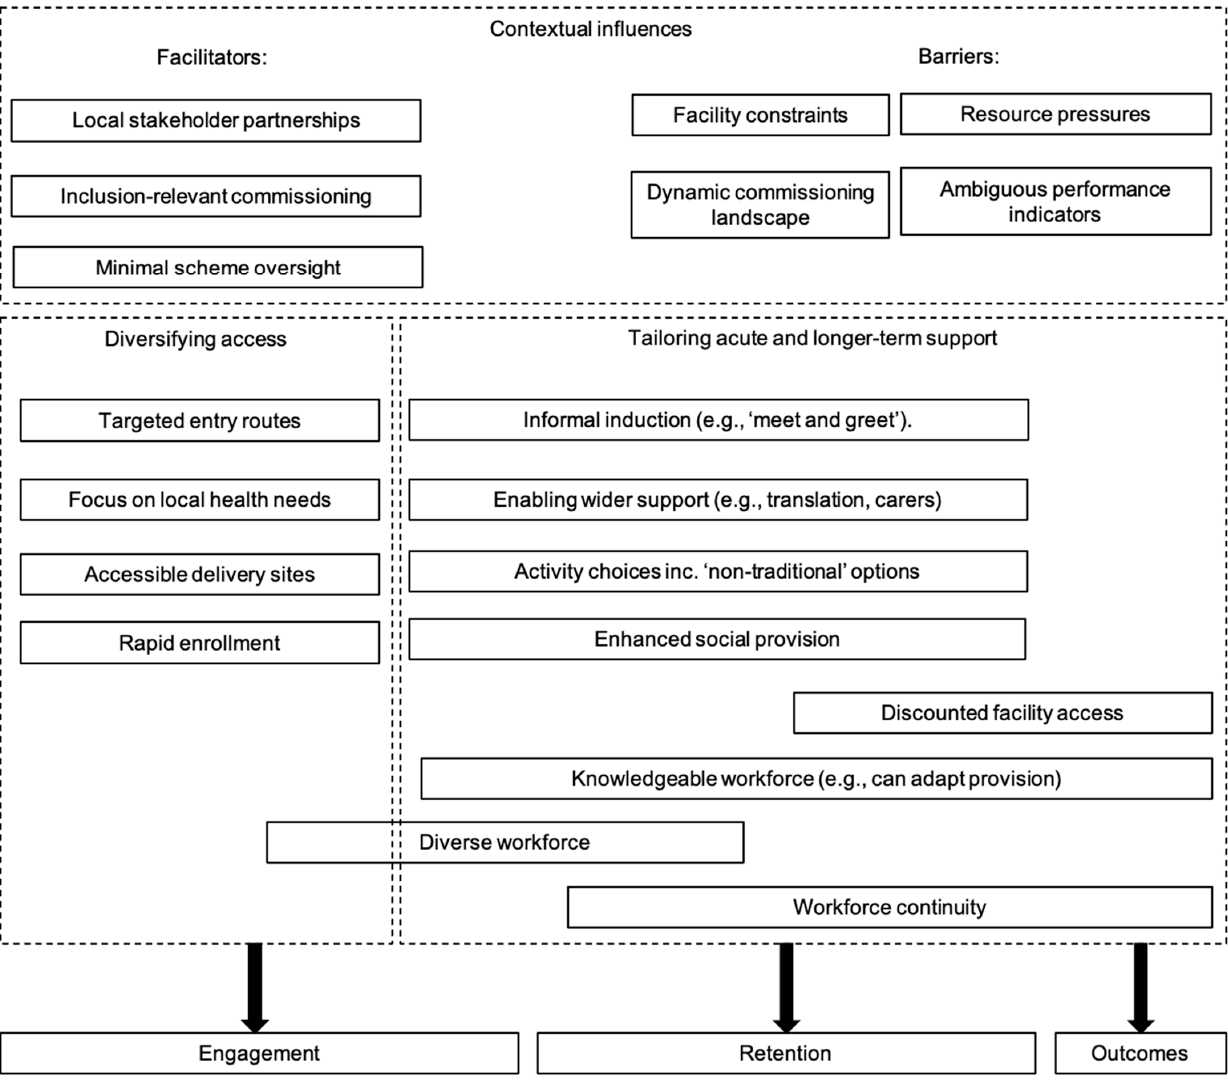
Figure 1. Conceptual schema of inclusive practices in exercise referral schemes.